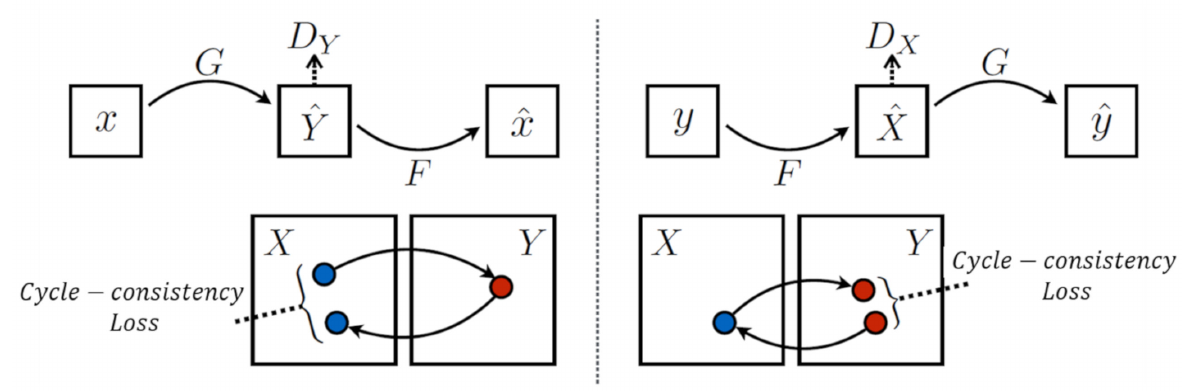
Figure 21. Cycle-consistency loss of CycleGAN (Cycle-consistency Generative Adversarial Networks)